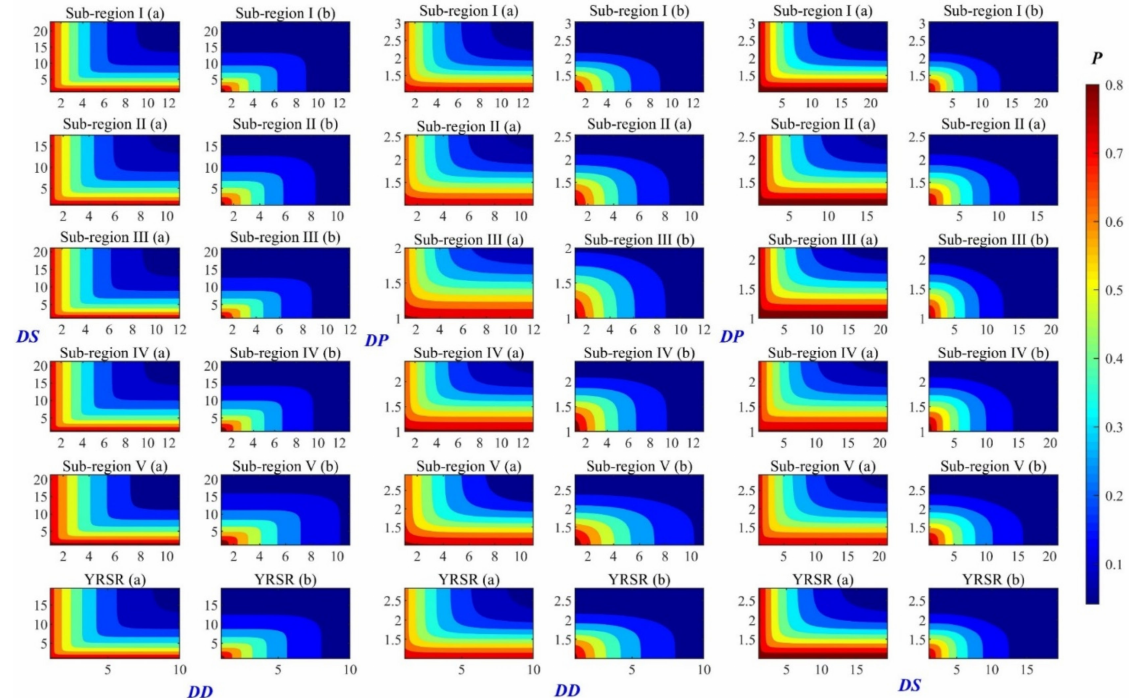
Figure 14. Bivariate probability of DD vs. DS , DD vs. DP and DS vs. DP : (a) “ ∪ ” bivariate probability; (b) “ ∩ ” bivari- ate